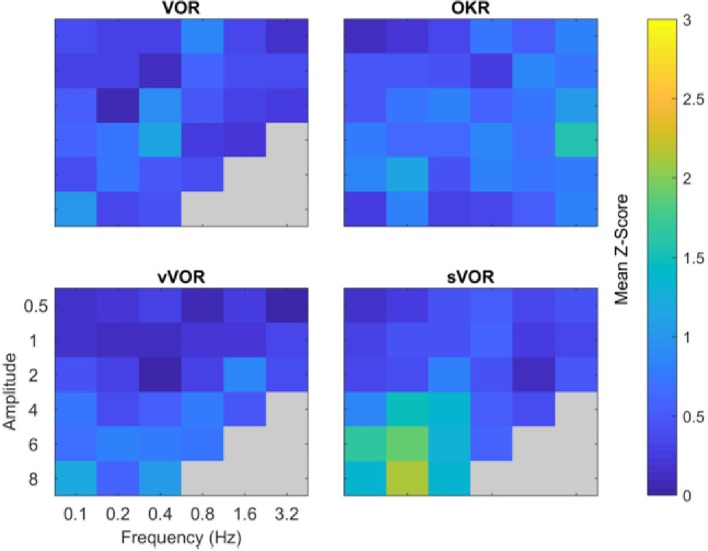
Summary of comparison of model and data for all amplitude and frequency combinations. The four panels depict the degree to which the model response matched the experimental data for the four conditions. The degree of similarity is expressed in terms of the number of standard deviations the model response was away from the mean behavioral response, cooler colors indicate a closer match. Across all amplitude and frequencies tested the model reproduces the experimental data well, with the possible exception of high amplitude, low frequency sVOR. Gray regions indicate conditions not measured in the experimental data.